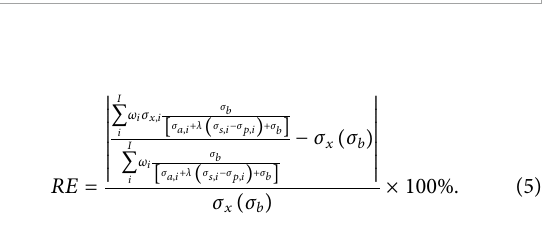
FIGURE 2 Variation trend of the escape cross-section by the subgroup level in different regions (Li et al.,